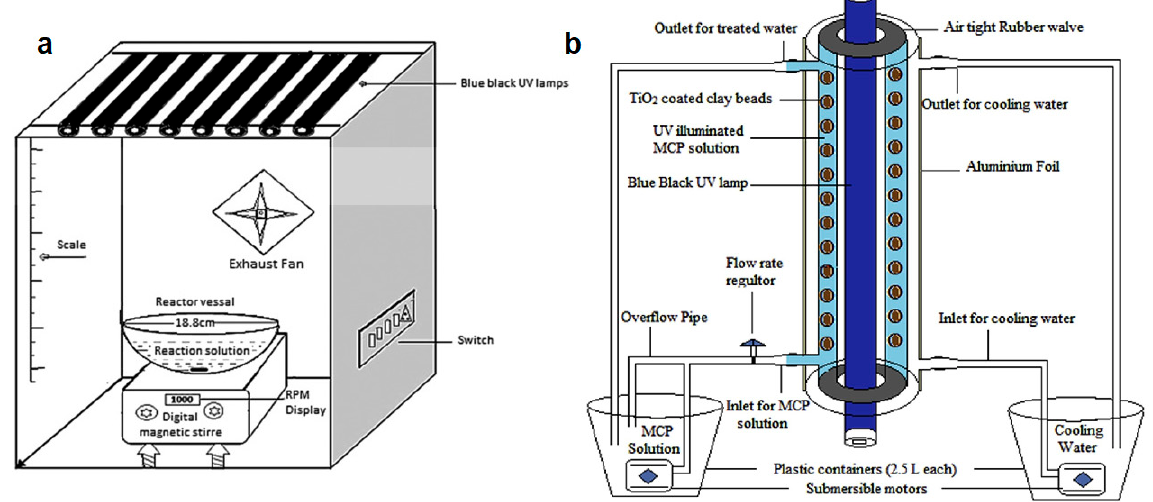
Figure 6. Photoreactors for pesticides degradation ( a ) Slurry reactor [123]; ( b ) Fixed bed recirculation reactor [124].